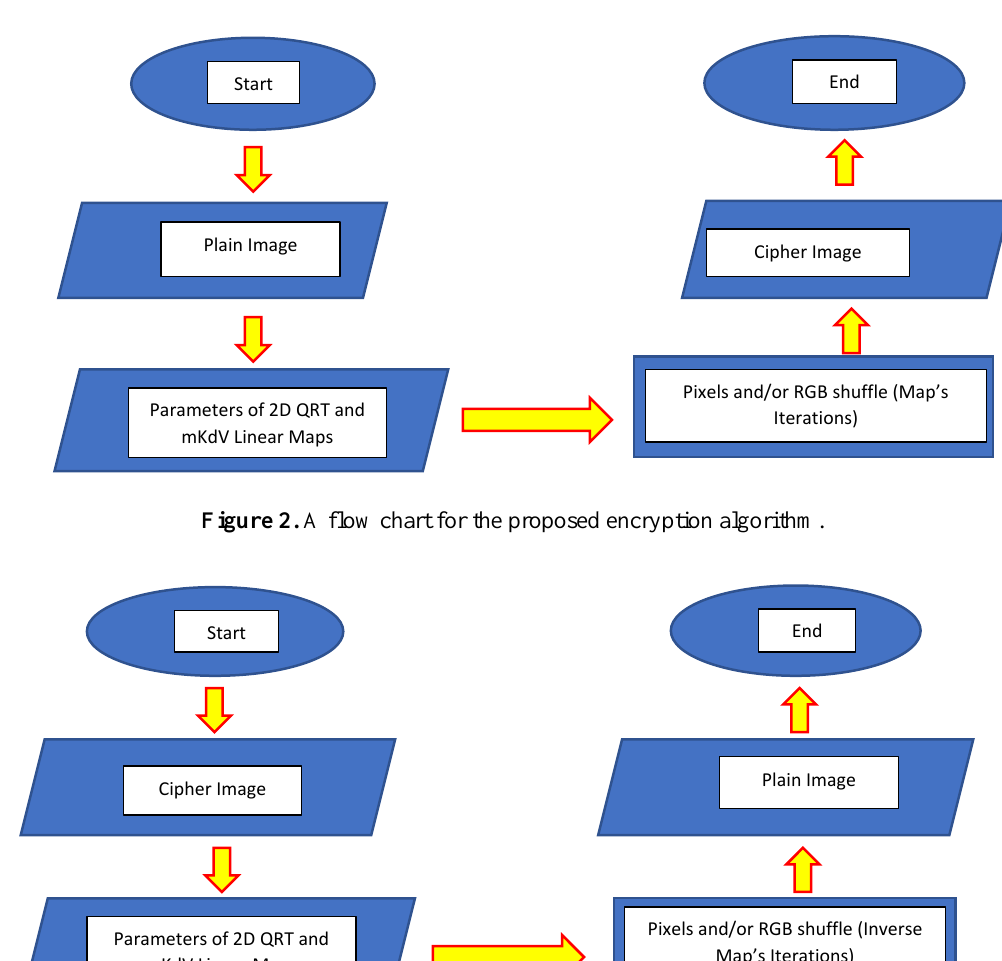
Figure 1. Examples of plain images: a fractal image (left), and a non-fractal image (right). Consider the image encryption-decryption scheme described in Figures 2 and 3 below.